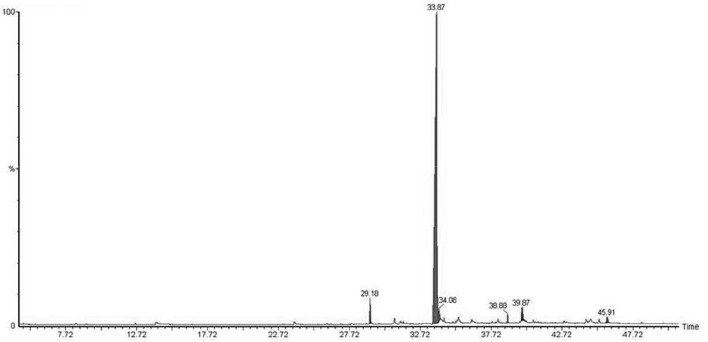
GC profile of M. piperita root exudates.